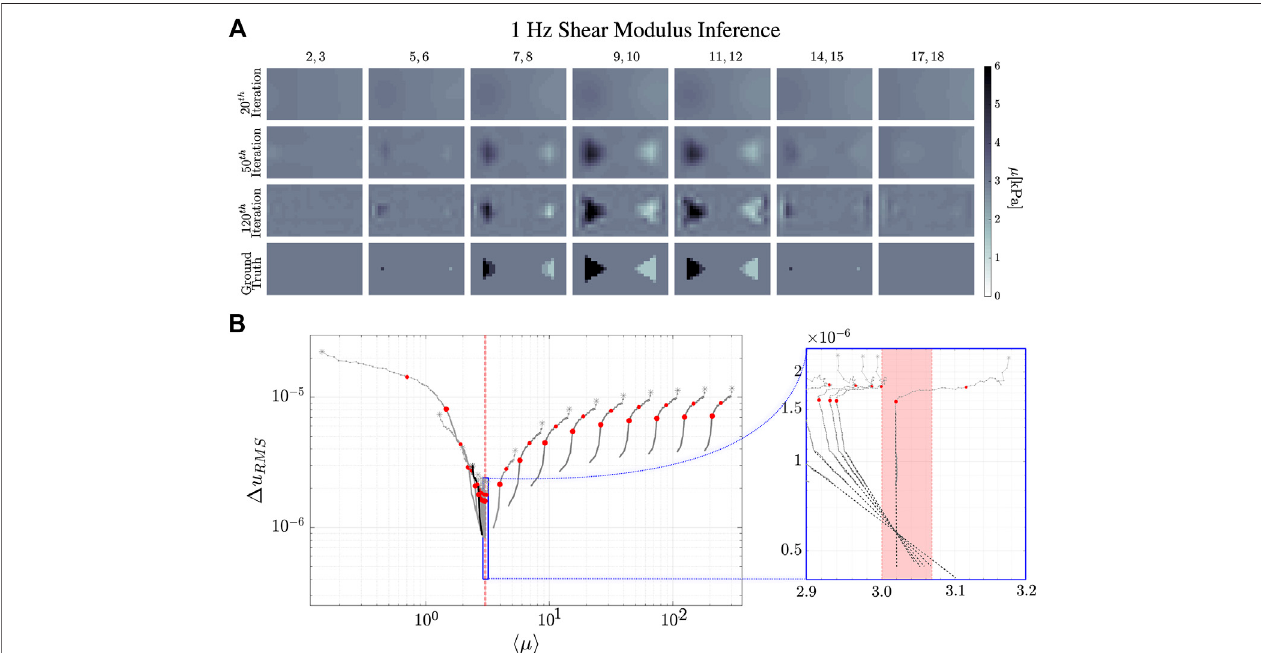
FIGURE 8 | Reconstruction evolution of the shear modulus, μ , at 1 Hz. (A) shows the reconstructed images of the shear modulus distribution inside the simulated phantom.Thecolumnimagesaretheaveragesofthenumbered ( xy ) -planes(toprow).Therowsarelabeledbytheiterationnumberoftheinference. (B) showsthelower dimensional trajectory of the shear modulus. As above, the shear modulus is measured in kilo-Pascals. The smaller diagram is a magni fi ed region near the converged values.Initialestimatesarenotedbyanasteriskandchangesindescentstrategyareindicatedbysmallandlargeredmarkers,asexplainedinthetext.Thelightred region represents the strip between the background value of the shear modulus and the ground truth mean value. The thicker trajectory is the one used to make the images in the above panel. Once again we see that convergence of shear modulus is much slower than hydraulic permeability, yet images for a wide range of these simulated phantoms all show the correct structure of inclusions. Best fi t lines are added to the zoomed in image to show that all the trajectories are approaching the same